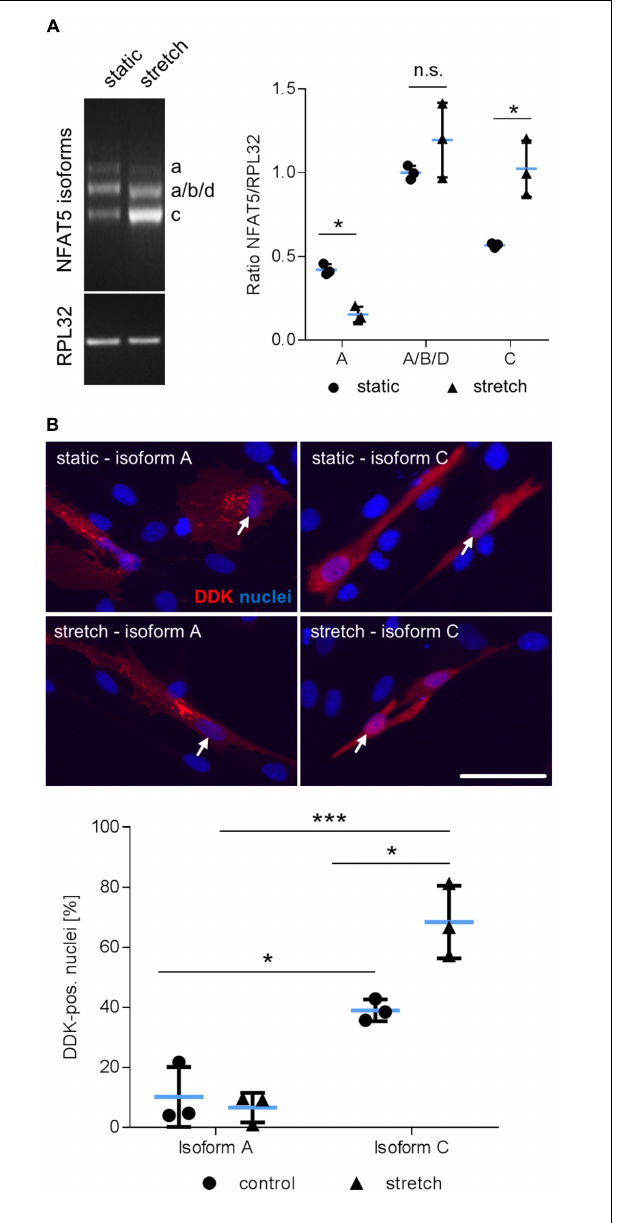
FIGURE 3 | Biomechanical stretch induces NFAT5c translocation into the nucleus. Expression of NFAT5 isoforms after stretch was quantitated by semi-quantitative PCR ( A , ∗ p < 0.05 vs. control, n = 3, unpaired, 2-tailed Student’s t -test, n.s.: not significant). DDK-specific immunostaining was used for detection of NFAT5 isoform localization in HUASMCs exposed to biomechanical stretch for 24 h, white arrows indicate localization of the nuclei, scale bar: 50 µ m). Automated quantification of DDK-positive nuclei in transfected cells 24 h after stretch ( B , ∗∗∗ p < 0.001, ∗ p < 0.05, n = 3, one-way ANOVA and Tukey